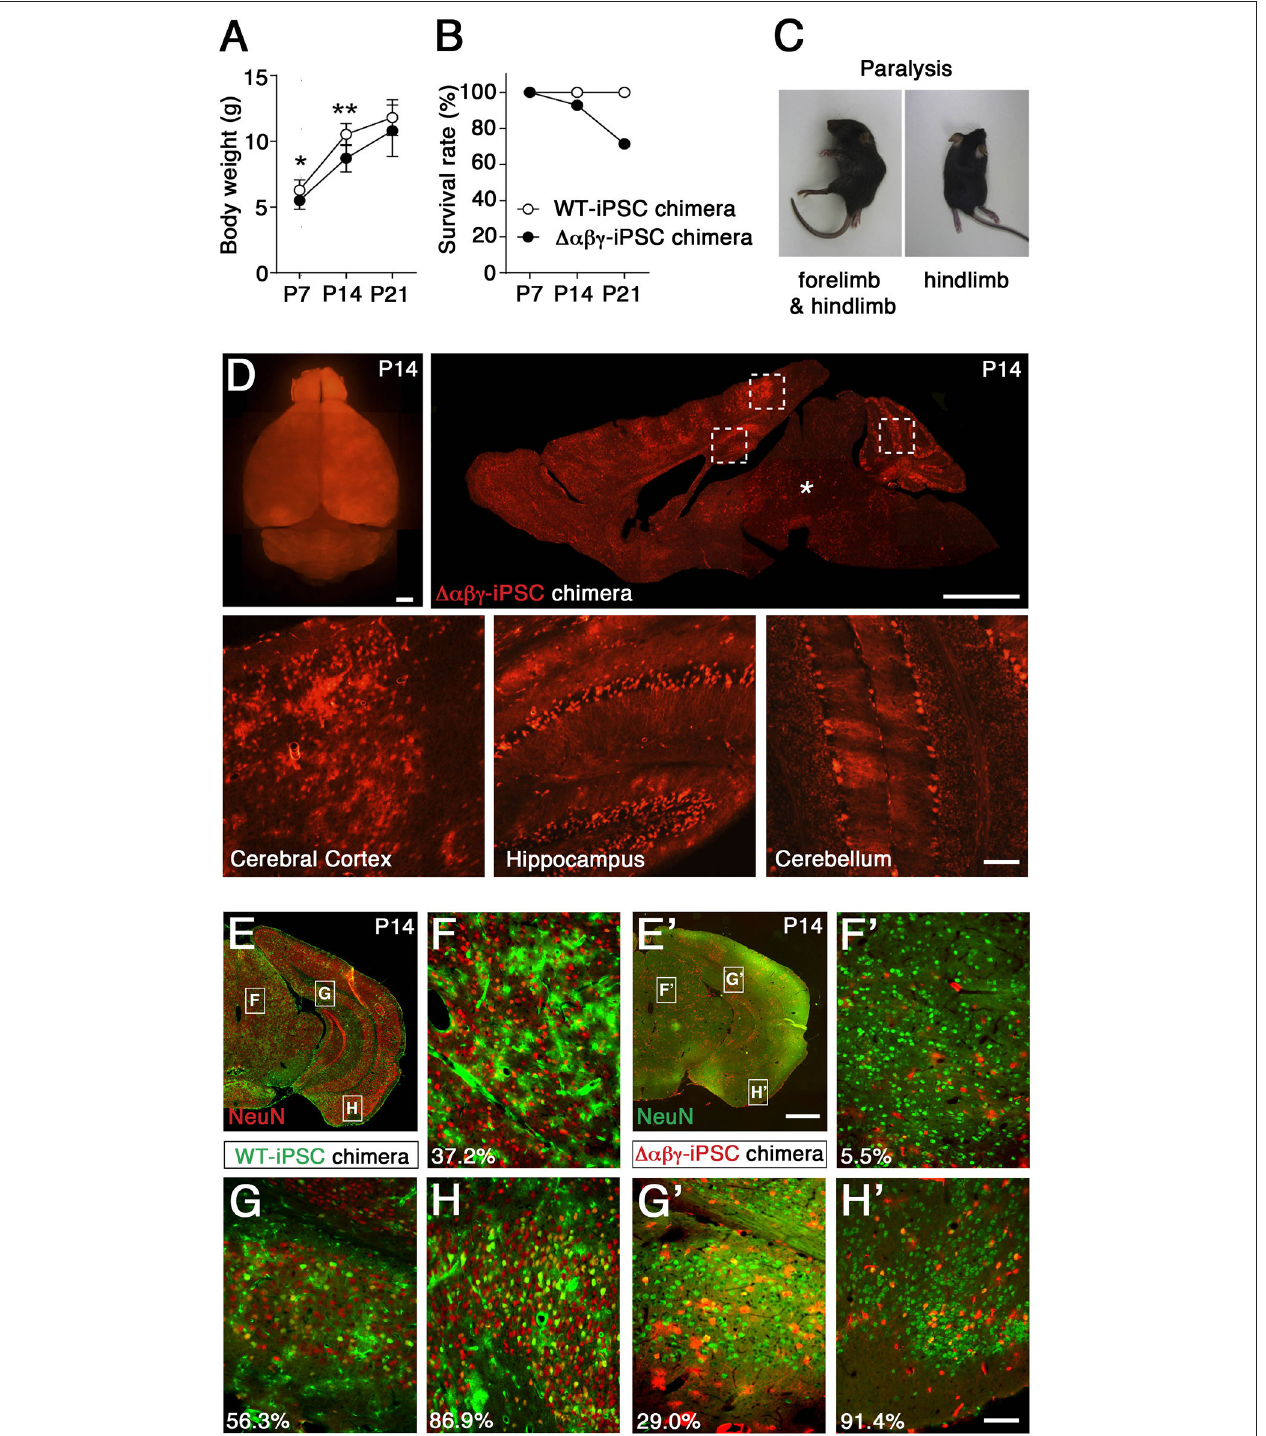
FIGURE 1 | Generation and analysis of chimeric mice with ∆αβγ -iPSCs. (A) Body weights were lower in ∆αβγ -iPSC chimeric mice ( n = 14 P7, 13 P14, and 10 P21 mice) than in WT-iPSC chimeric mice ( n = 5 P7, 5 P14, and 5 P21 mice). Data are shown as mean ± SD . * P < 0.05, ** P < 0.01 for WT vs. ∆αβγ by Student’s t -test. (B) Survival of chimeric mice (WT-iPSC n = 20; ∆αβγ -iPSC n = 14). (C) Paralysis was noted in some ∆αβγ -iPSC chimeric mice at about P14. (D) A P14 chimeric mouse showing intense tdTomato + signals in several regions of the brain, including the cerebral cortex, hippocampus, and cerebellum (outlined in squares), but not the brainstem (*). (E–H’) Representative images of WT-iPSC (E–H) or ∆αβγ -iPSC (E’–H’) chimeric mice. Numbers at lower left indicate the percentage of surviving neurons (yellow-colored) in each panel. Note that WT iPSCs were labeled with not tdTomato but GFP (E–H) . Bars: 1 mm in ( D , upper, E’ ), 100 µ m in ( D , lower, H’ ). The TAF7 transgene was included in the ∆αβγ -iPSC chimeras, but not in the WT-iPSC chimeras.